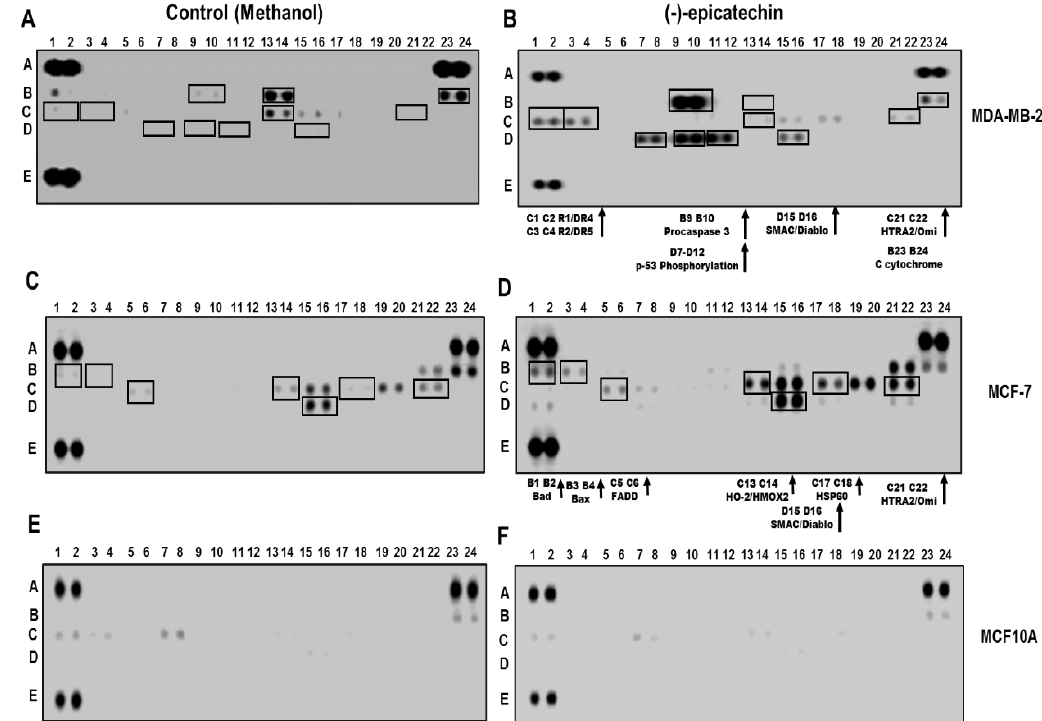
Figure 4. Human Apoptosis Antibody Array analysis in response to (−)-epicatechin. Whole cell lysates from MDA-MB-231, MCF-7, and MCF10A cell lines were prepared from either cells left untreated or treated with (−)-epicatechin. ( A ) and ( B ) MDA-MB-231, ( C ) and ( D ) MCF-7, and ( E ) and ( F ) MCF10A cell lines. Each protein was spotted in duplicate. The pairs of dots in each corner are the positive controls. For the samples exposed to (−)-epicatechin, each pair of the most positive protein dots is denoted by coordinates (letter and number), along with the identity of the corresponding protein.